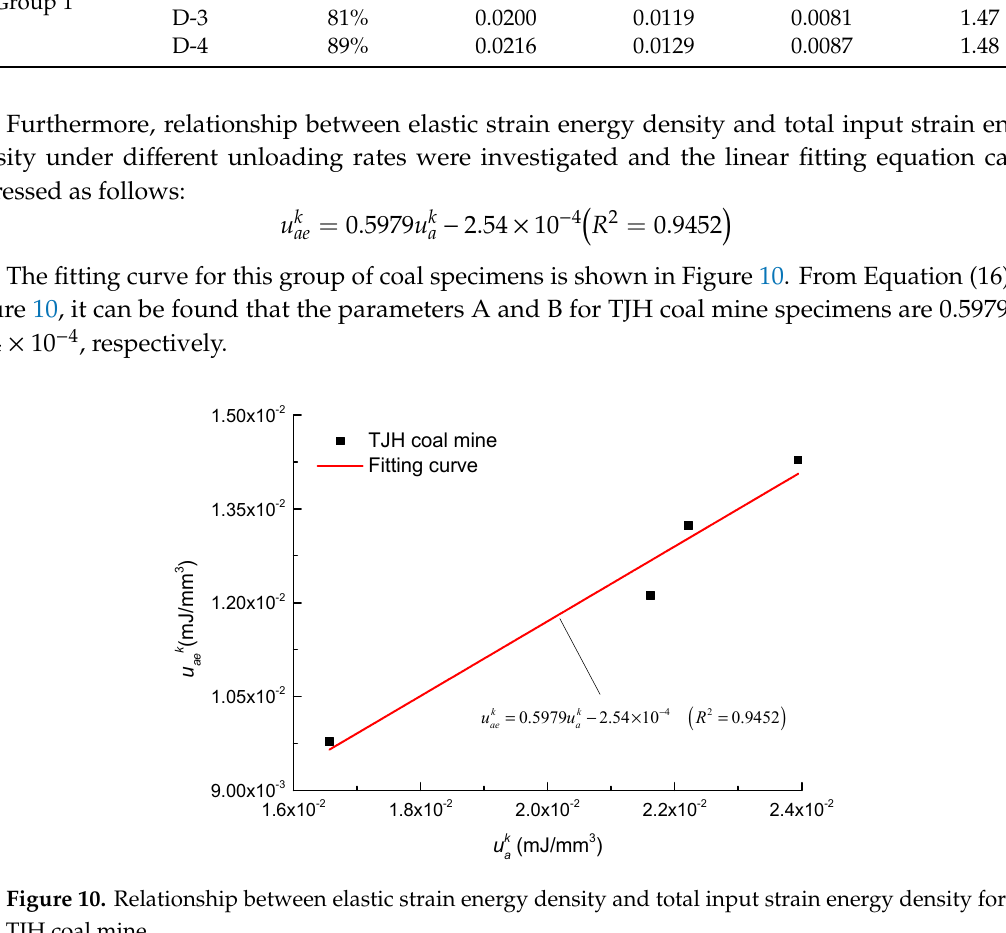
Figure 11. Stress–strain curves of four typical specimens in TJH coal mine.